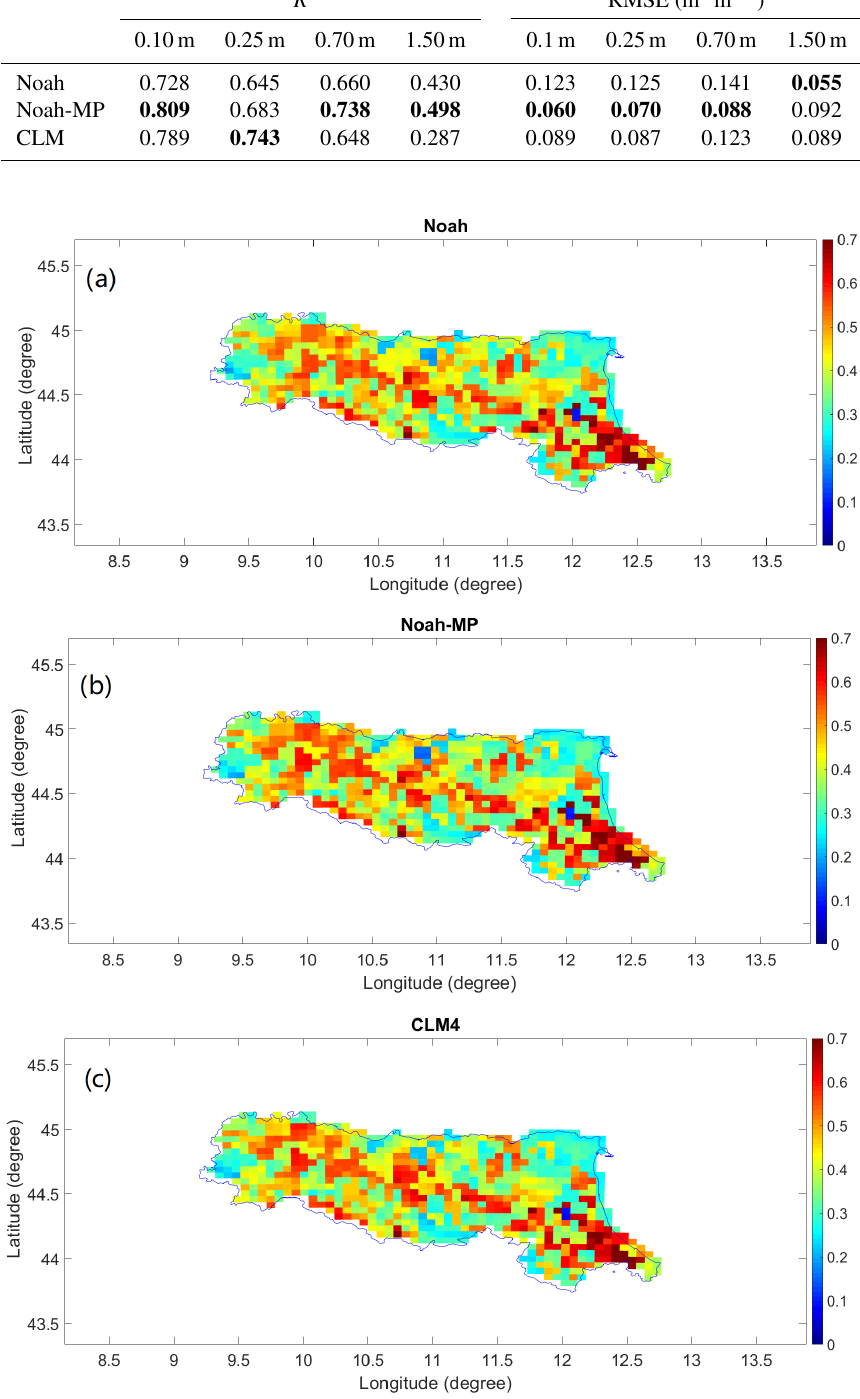
Figure 5. Rainfall evaluation: spatial distribution of the correlation coefficient R of (a) Noah, (b) Noah-MP, and (c) CLM4.